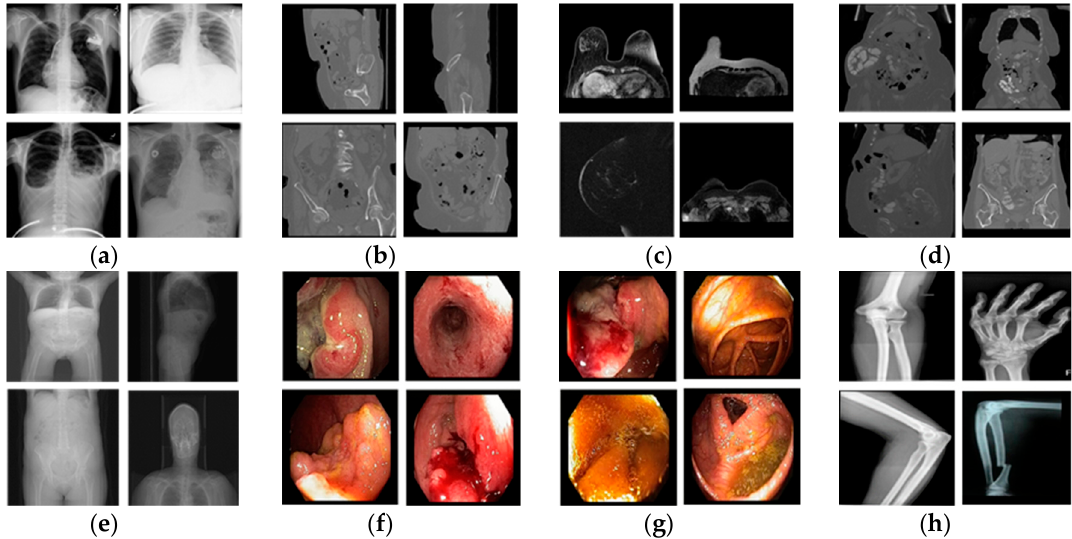
Figure 7. Selected example images for showing high intra-class variance; ( a ) chest X-ray in Figure 5b-1; ( b ) urography CT in Figure 5b-2; ( c ) breast MRI in Figure 5b-3; ( d ) uterus CT in Figure 5b-5; ( e ) CT topogram in Figure 5c-3; ( f ) rectum in Figure 5d-1; ( g ) colon in Figure 5d-2; ( h ) bones X-rays in Figure 5e-6.